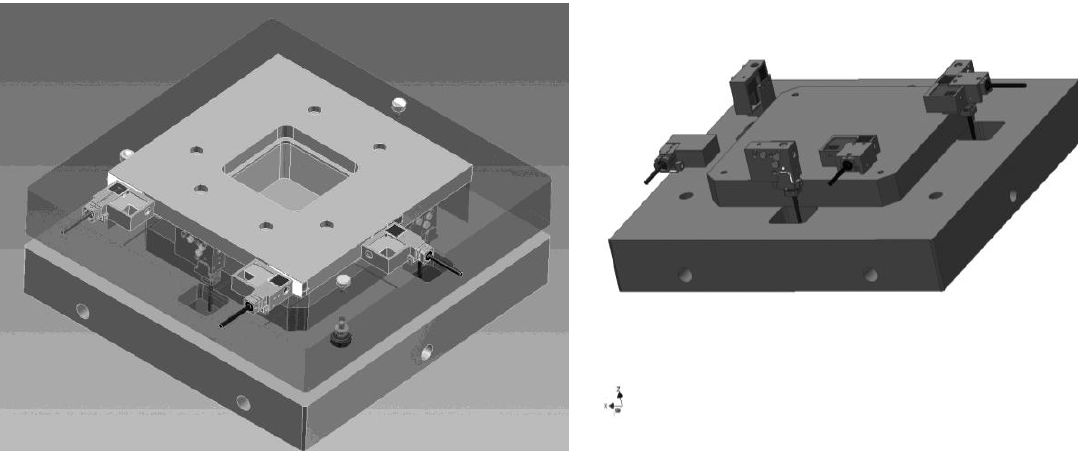
Figure 1. Configuration of the setup ( left ) together with the arrangement of the interferometers in all measuring axes ( right